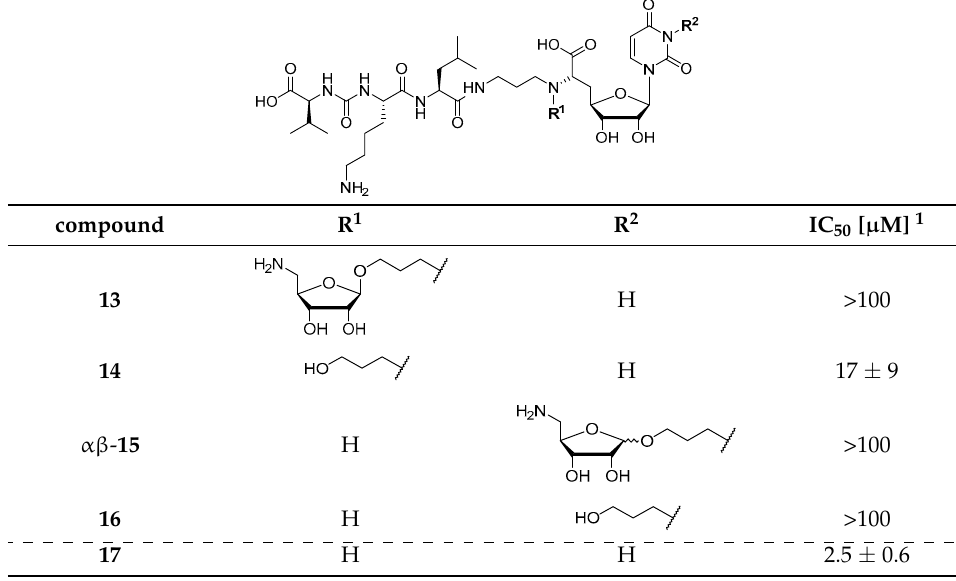
Table 1. In vitro inhibitory activities of muraymycin analogues 13–16 against MraY from S. aureus .